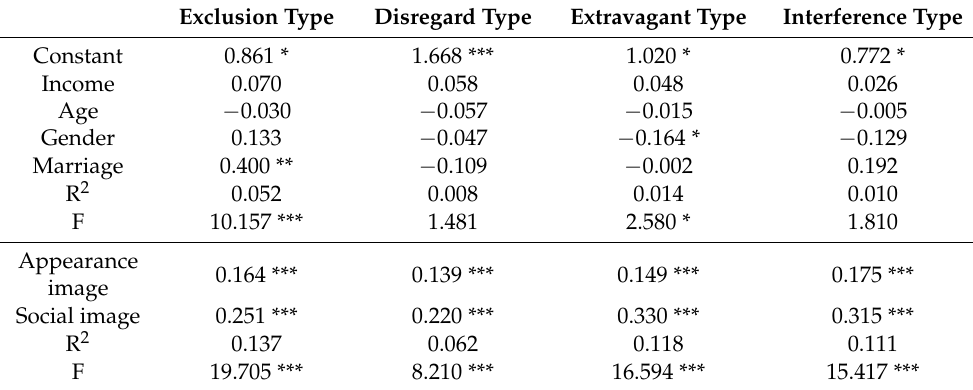
Table 4. Predictive effect of image construction on food waste